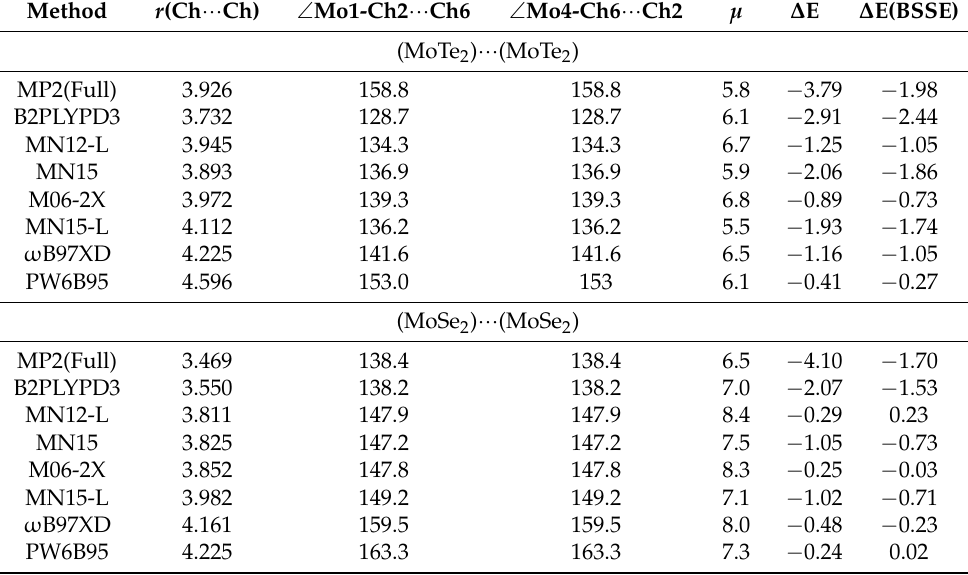
Table 2. MP2(Full) and DFT/def2-TZVPPD computed Ch ··· Ch bond distances (r(Ch ··· Ch)/Å), Mo–Ch ··· Ch bond angles ( ∠ Mo–Ch ··· Ch/deg), dipole moments ( µ /Debye), uncorrected and BSSE corrected binding energies ( ∆ E and ∆ E(BSSE) in kcal mol − 1 , respectively) of (MoCh 2 ) 2 (Ch = S, Se, Te) dimers.